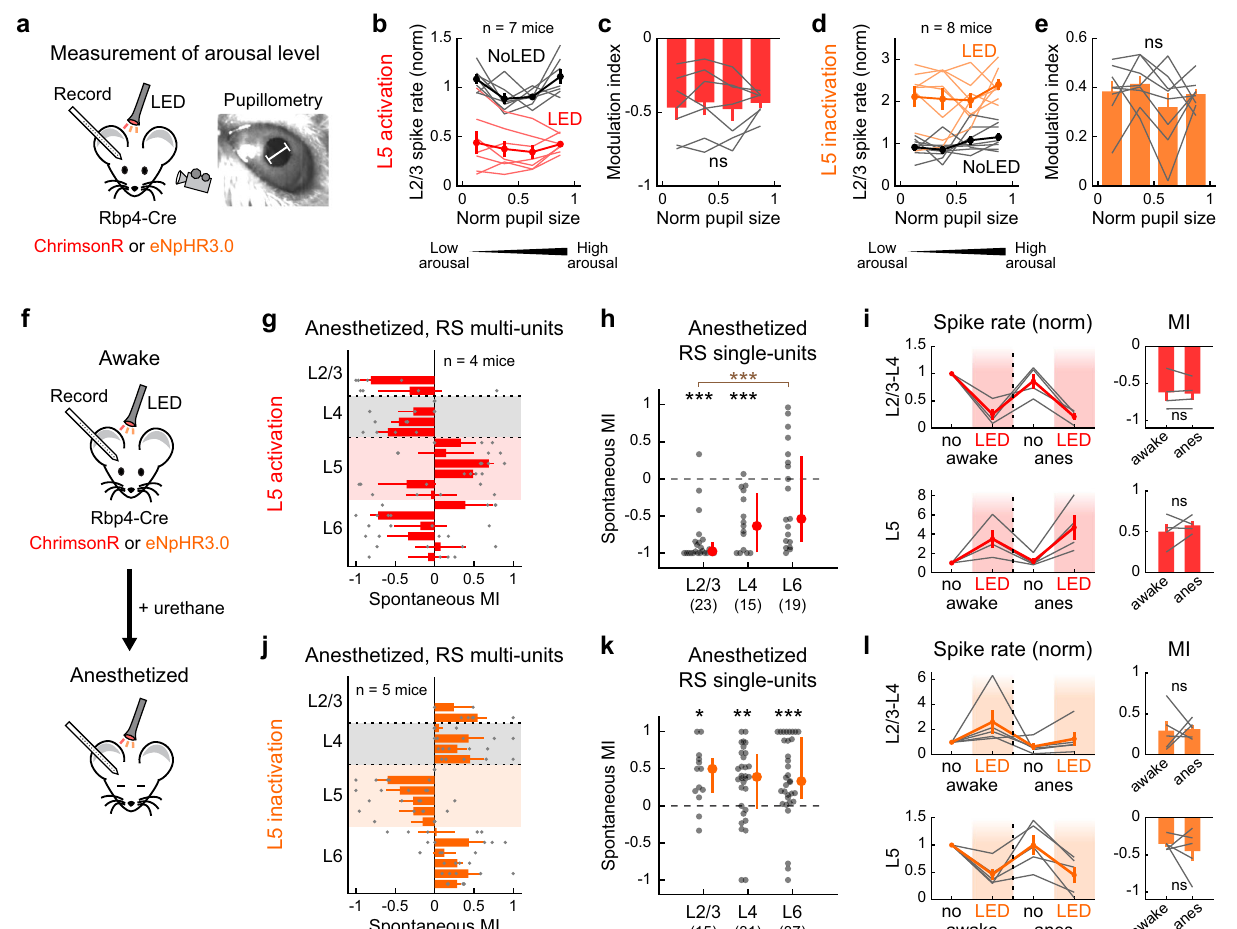
Fig. 2 Optogenetic activation of L5 suppresses super fi cial layers regardless of brain states. a Left, schematics for the experimental setup with pupil monitoring. Right, representative pupil camera image. White bar indicates pupil diameter. b Dependence of L2/3 multi-unit spontaneous fi ring rate on pupil diameter with (red) and without (black) L5 activation ( n = 7 mice). Thin lines show individual mice, and thick lines indicate mean ± SEM. Firing rate is normalized to that of No LED trials. Data are grouped into four bins of arousal level based on normalized pupil diameter in each mouse. c Dependence of MI of L2/3 multi-unit activity on pupil diameter during L5 activation. Data are mean ± SEM, overlaid with individual mice (n = 7 mice). p = 0.96. One-way ANOVA. d , e Same as in b , c but for L5 inactivation ( n = 8 mice). p = 0.43. f Schematics for A1 recordings in awake and anesthetized states. g – i Data for L5 activation with ChrimsonR under urethane anesthesia. g Laminar pro fi le of MI for the spontaneous fi ring of RS multi-units during L5 activation, overlaid with individual data points ( n = 4 mice). Red shade, L5. Results are mean ± SEM. h Scatter plots showing MI for the spontaneous fi ring of RS single-units in each layer across mice (4 mice; n = 23, 15, 19 for L2/3, L4, L6). Red dots and bars represent median and 25th and 75th percentiles. *** p < 0.001. Individual groups: two-sided Wilcoxon signed rank test with Bonferroni correction (black asterisks). Comparisons across groups: two-sided Wilcoxon rank sum test with Bonferroni correction (brown asterisks). i Left, spontaneous multi-unit fi ring rates normalized to no LED condition in the awake state separately for L2/3 – L4 (top) and L5 (bottom). LED and No LED trials were interleaved in each brain state. Red line plot indicates mean ± SEM. Gray lines show individual mice. Right, summary plots comparing MI for spontaneous activity between awake and anesthetized states ( n = 4 mice; L2/3 – L4: p = 0.67; L5: p = 0.45; two-sided paired t -test). j – l Same as in g – i but for L5 inactivation with eNpHR3 under urethane anesthesia (5 mice, n = 15, 31, 37 for L2/3, L4, L6). * p < 0.05, ** p < 0.01. See Supplementary Data 1 for additional statistics. Source data are provided as a Source Data fi evoked activity broadened the tuning of L2/3 units without affecting their preferred frequency (L2/3: p = 0.0021; L4: p = 1.0; L6: p = 1.0, Wilcoxon signed rank test; Fig. 3k and Supplemen- tary Fig. 3d). Application of threshold-linear fi tting to each tone- responsive unit showed that the impact of L5 inactivation on super fi cial layers was a mixture of additive and multiplicative (Fig. 3l – n). Together, our results from bidirectional manipula- tions of L5 revealed that both photoevoked and endogenous layers. The mixed divisive and subtractive transformations may indicate cortical inhibitory mechanisms 39 in L5-dependent suppressive gain control of super fi cial layers.